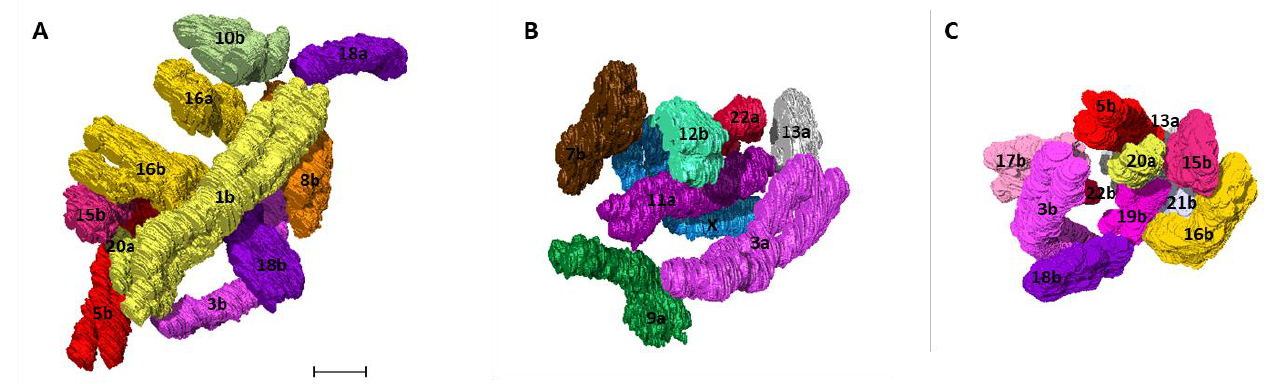
Figure 8. Neighborhood clusters. 3D clusters of the closest spatial neighbors for human chromosome ( A ) 1b ( B ) 11a ( C ) 19b detected by 3D analysis using Avizo. Colors of the chromosomes correspond to the pseudocolor karyotype (Figure 4). Scale bar—1µm.